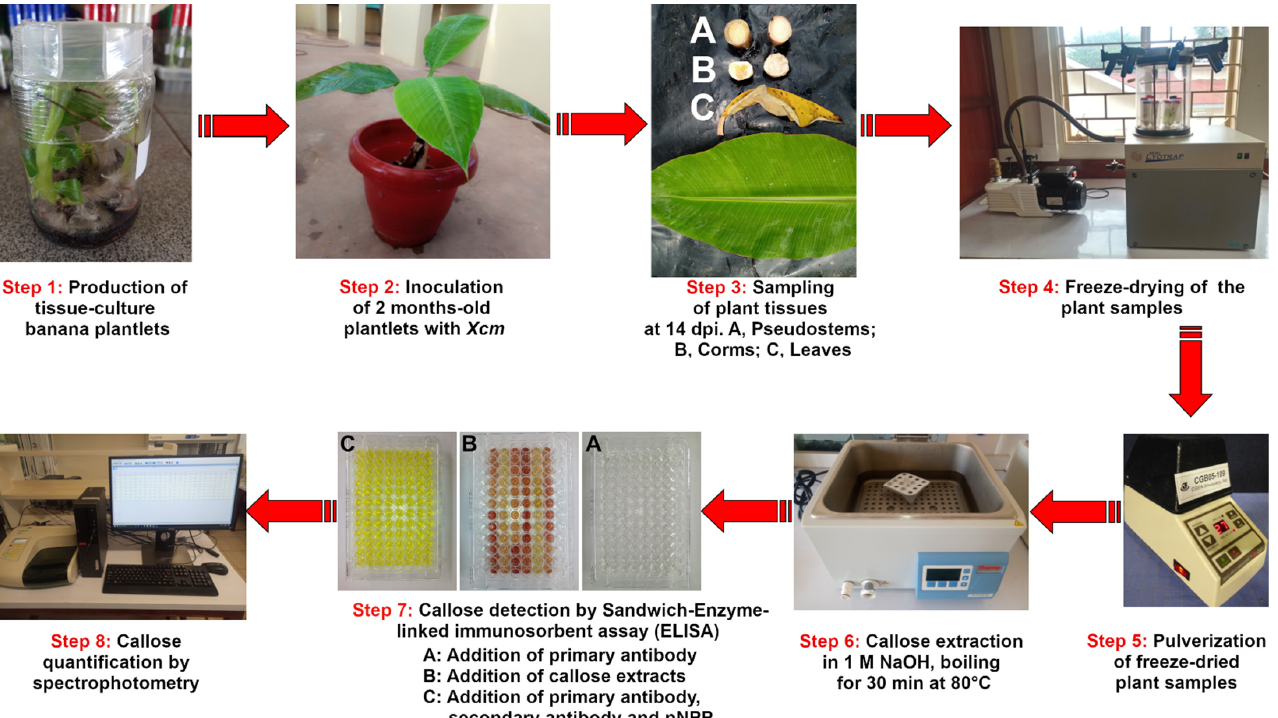
Figure 1. Schematic illustration of the major steps involved in callose